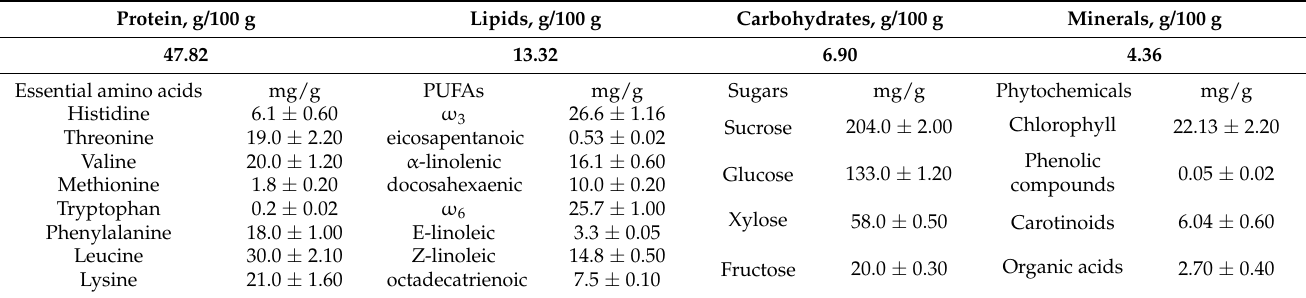
Table 5. Indicators of biological value of dry biomass of microalgae C. sorokiniana . Protein, g/100